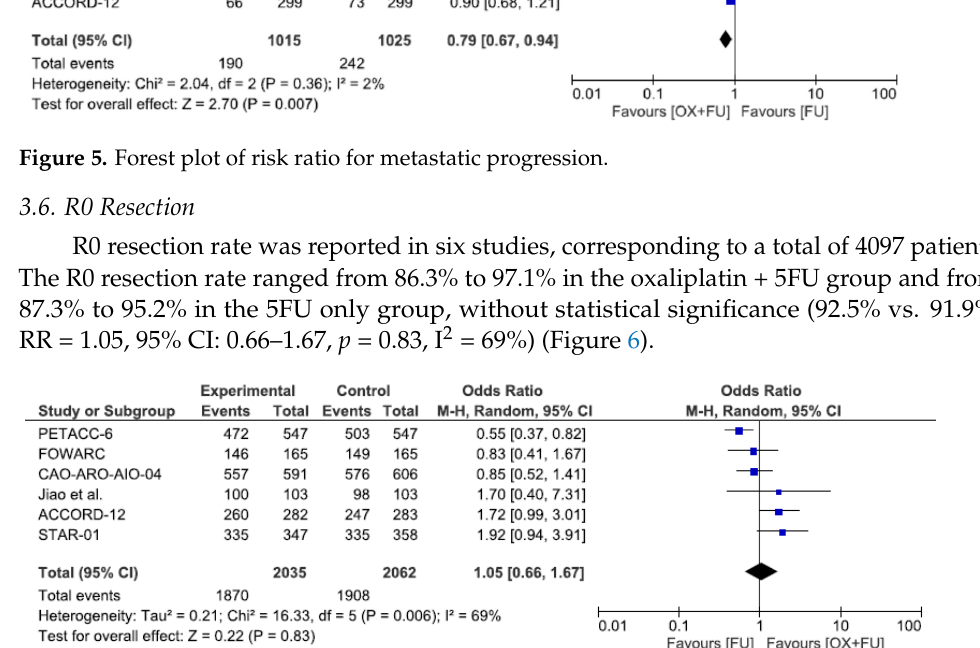
Figure 6. Forest plot of odds ratio for R0 Resection.